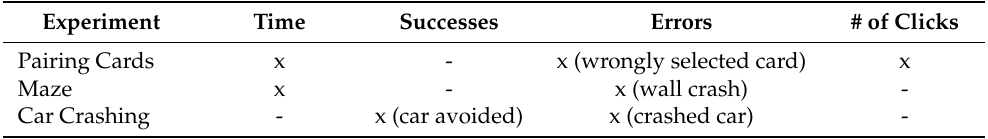
Table 1. Variables registered for each game.